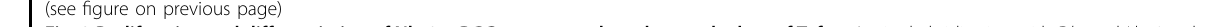
Fig. 3 Proliferation and differentiation of Nkx2.1-RGCs were not altered upon the loss of Tcf4. a In situ hybridization with Dlx1 and Lhx6 probes from WT and Tcf4 cKO mice at E15.5. Higher magni fi cation images of the inserts showed on the right panels. Scale bar: 100 μ m. b Representative images of immunostaining for GFP, Olig2, and BrdU. The right panel shows the higher magni fi cation of the inserts. Scale bar: 100 μ m. c , d Quanti fi cation of the proliferating progenitors ( c ) and proliferating OPCs ( d ). Student ’ s t test was used to compare two groups. Data are presented as mean ± SEM. n.s. nonsigni fi cant. e , f Immunostaining for PDGFR α ( e ) and Ascl1 ( f ). Scale bar: 100 μ m. g , h Quanti fi cation of PDGFR α -positive ( g ) and Ascl1-positive ( h ) progenitors. Student ’ s t test was used to compare two groups. Data are presented as mean ± SEM. n.s. nonsigni fi cant. i Representative images show immunostaining for GFP and Olig2 at P7, P15, and P28 from both WT and Tcf4 cKO OBs. Neurons are negative for Olig2 and display distinct morphology (arrowheads). Scale bar: 50 μ m. j Quanti fi cation of neurons at different developmental stages of OB as indicated. Student ’ s t test was used to compare two groups. Data are presented as mean ± SEM. n.s. nonsigni fi